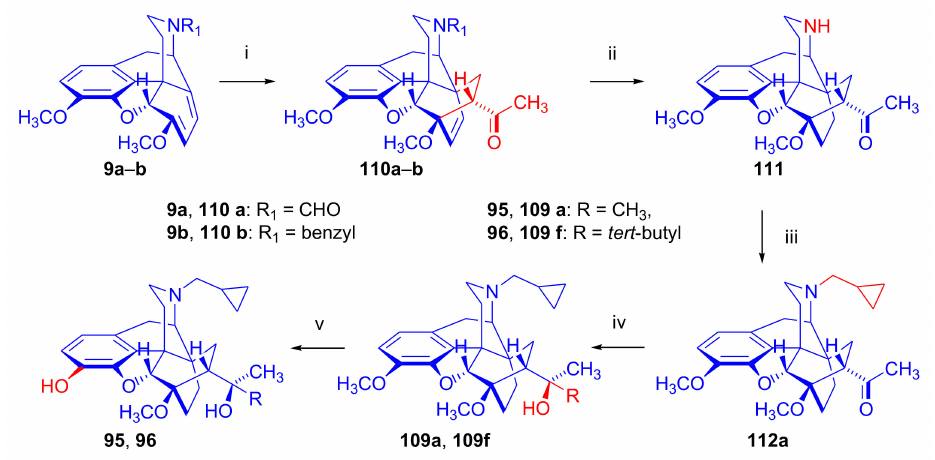
Figure 34. Synthesis of diprenorphine and buprenorphine from N 17 -benzyl-northebaine and N 17 - formyl-northebaine. Reagents and conditions : (i): methyl vinyl ketone, reflux, 1 h; (ii): (A) H 2 , Pd-C, EtOH, 60 ◦ C, 5 bar, or (B) (R = CHO) HCl in EtOH, reflux, 4 h; (iii): cyclopropylmethyl bromide, NaHCO 3 , 90 ◦ C, 20 h; (iv): methylmagnesium iodide or tert -butylmagnesium chloride, diethyl ether-toluene, 2 h; (v): KOH, diethylene glycol, 210 ◦